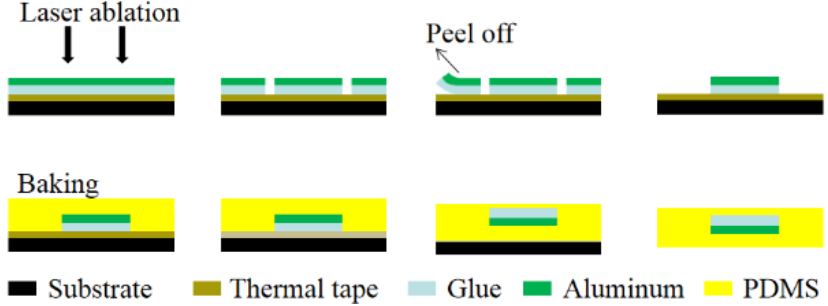
Figure 1. Process of laser cutting metal foil to prepare stretchable electrode.